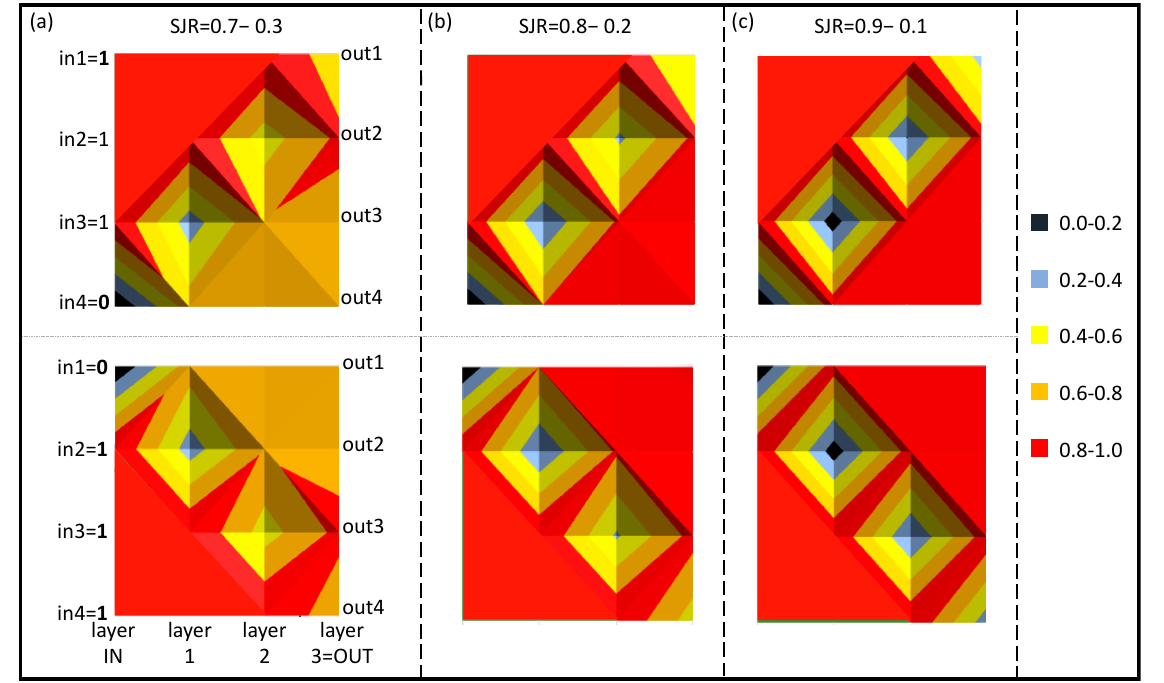
Figure 6. Represents the evolution of the intensities in the three layers with respect to the three input configurations, 1 − 1 − 1 − 0 and 0 − 1 − 1 − 1, for the three cases of imbalance: ( a ) SJR = 0.7 − 0.3; ( b ) SJR = 0.8 − 0.2; ( c ) SJR = 0.9 − 0.1.